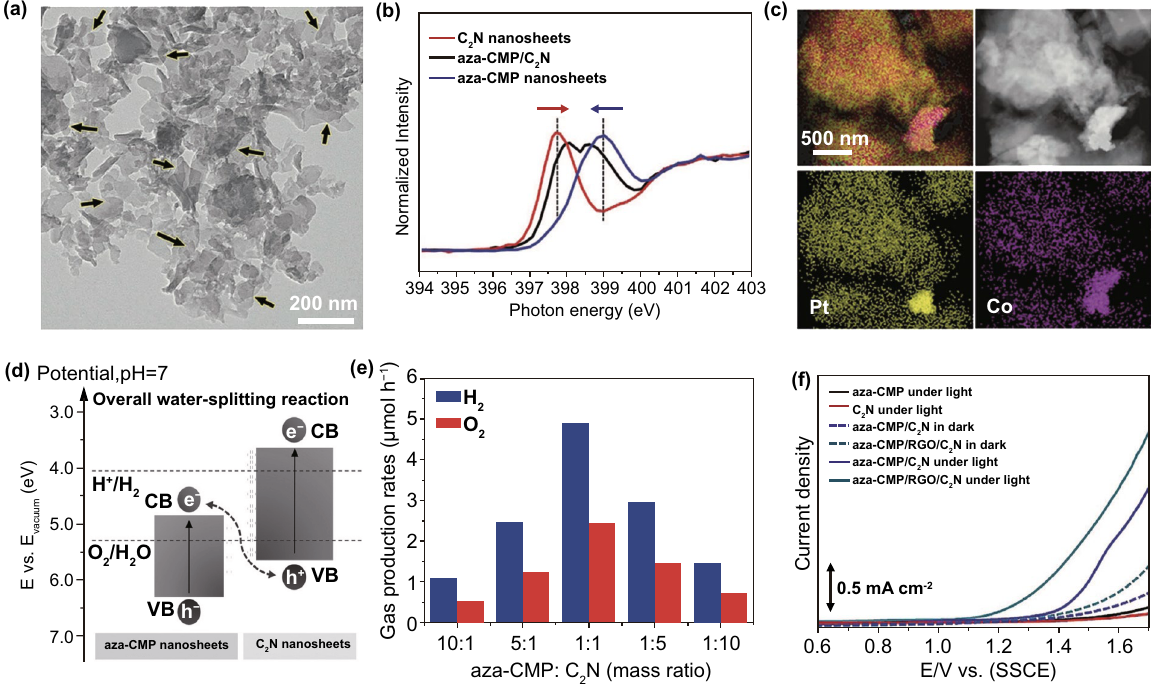
Fig. 24 a TEM image. b NK‑edge XANES of aza‑CMP, C 2 N, and aza‑CMP/C 2 N. c HAADF‑STEM images and elemental mapping (Pt‑labeled C 2 N and Co‑labeled aza‑CMP). d Overall H 2 O splitting activity. e Scheme showing aza‑CMP/C 2 N hetero‑structures electronic band structures. f J–V curves of catalysts in dark and under light irradiation. Adapted with permission from Ref.